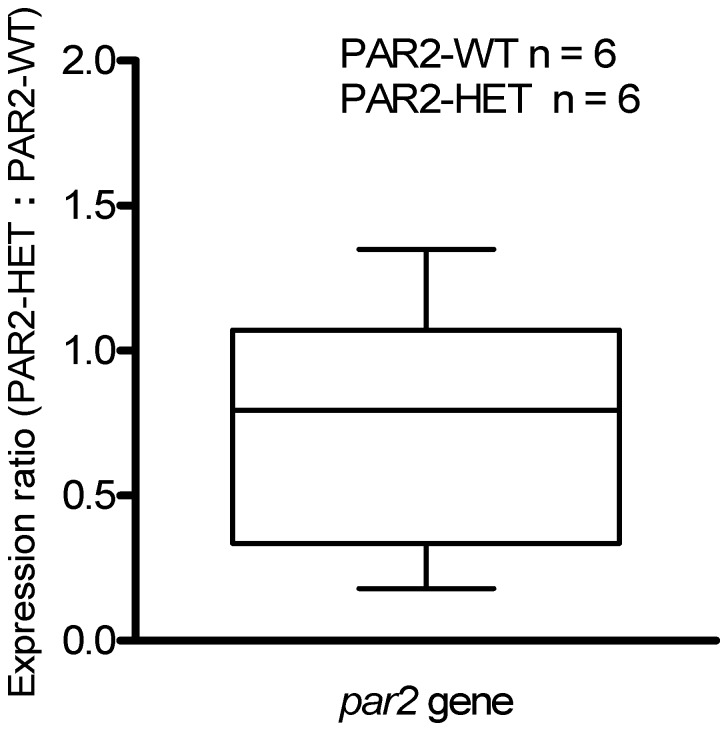

par2 mRNA expression (PAR2-HET relative to PAR2-WT) in mouse aortas.
par2 mRNA from mouse aorta preparations was measured by real-time PCR. par2 gene threshold cycle (CT) values were normalized to gapdh gene CT values. Bars represent the 95% C.I. par2 PCR reaction efficiency: 0.9517, gapdh PCR reaction efficiency: 0.9574. Expression ratio of par2 gene in PAR2-HET∶PAR2-WT is not significantly different from unity, P>0.05.